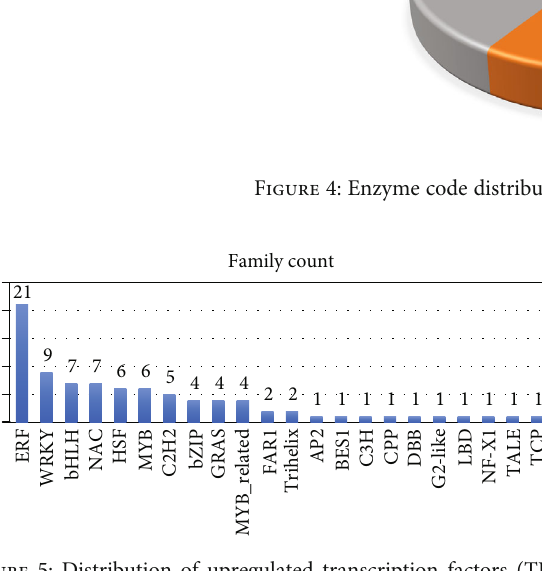
Figure 5: Distribution of upregulated transcription factors (TFs) under heat